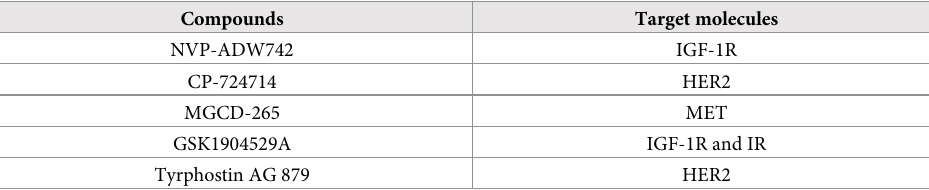
Table 3. Selected compounds that attenuate EBOV Δ